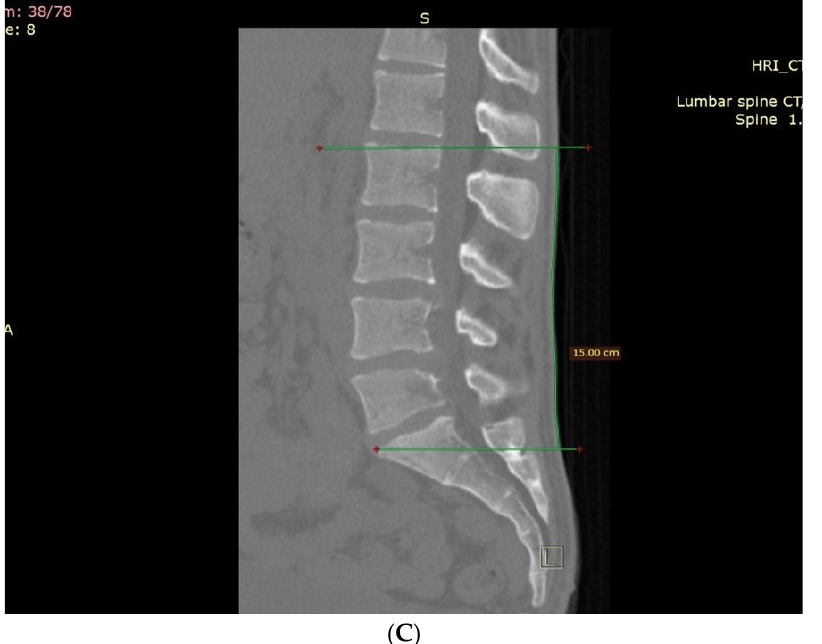
Figure 2. MMST Measurement. ( A ) MMST PSIS LANDMARK on CT axial–sagittal views. ( B ) MMST PSIS Qaudal starting point. MMST was measured by marking the most prominent point of the Posterior Superior Iliac Spine (PSIS), as measured by CT (Marked arrows). On that level, scrolling back to a midline sagittal plane, a parallel line was drawn to the skin surface as described previously. ( C ) MMST complete CT measurement. From that point, a 15 cm skin surface line was drawn cranially. The caudal and cephalad spinal levels were measured as described before.